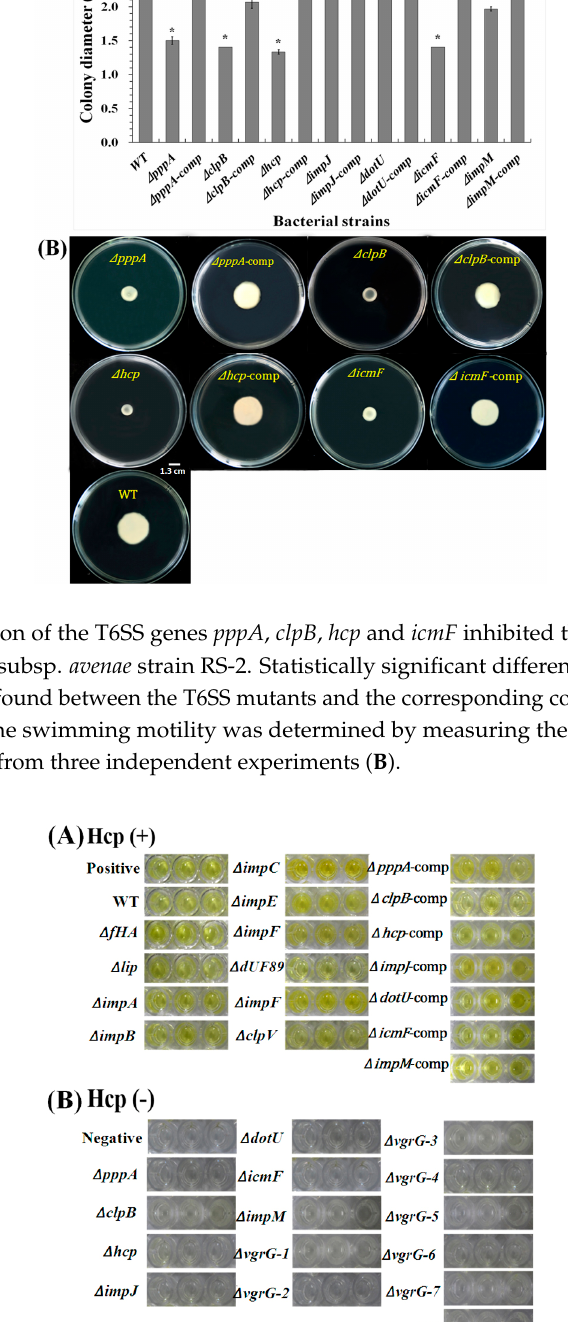
Figure 9. ELISA detection for the secretion of Hcp effector protein by the wild-type, the T6SS mutants and the corresponding complemented strains of Acidovorax avenae subsp. avenae strain RS-2.( A ) The positive reaction (P/N value ≥ 2.1); ( B ) The negative reaction (P/N value < 2.1). The purified Hcp-His fusion protein and His protein were used as the positive and the negative control, respectively. The experiment was conducted three times with 3 replicates.